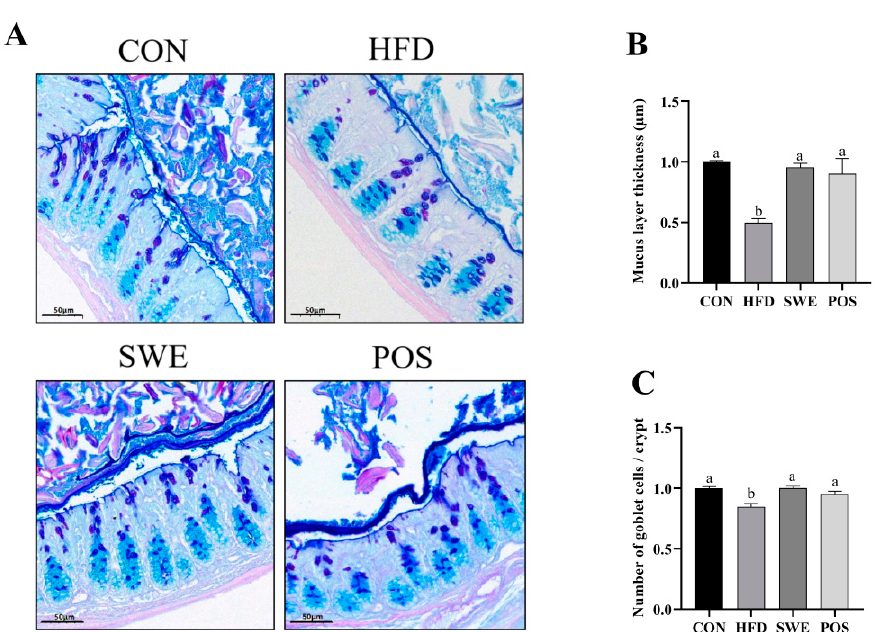
Figure 3. Effects of SWE on colonic mucus thickness and number of goblet cells in HFD-fed mice. ( A ) representative AB/PAS-stained distal colon sections showing mucus layer thickness and goblet cells within the colon tissue, scale bar: 50 µ m, ( B ) manually measured colonic mucus layer thickness, ( C ) number of goblet cells per crypt (5–8 sections per animal). Values are expressed as mean ± S.E.M. Data with different superscript letters are significantly different ( p < 0.05). n = 4–6 per group.